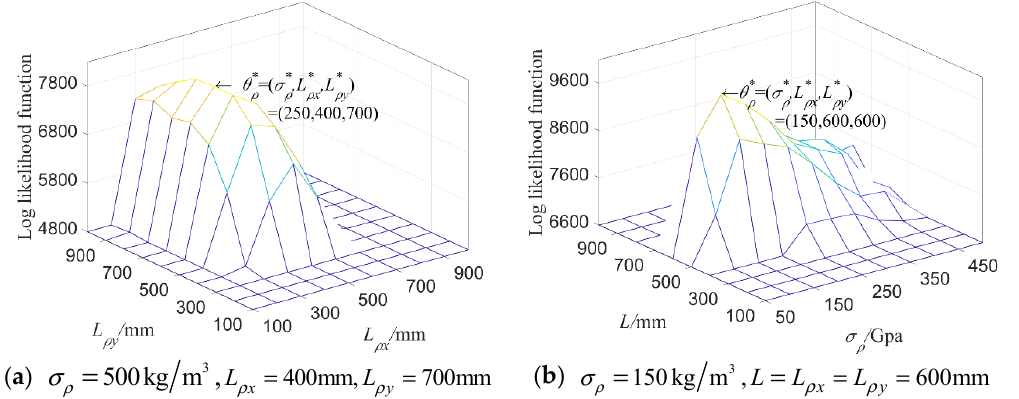
Figure 15. ˆ L ( θ ) of the first 6 natural frequencies when inputting different parameter settings of ρ random field .